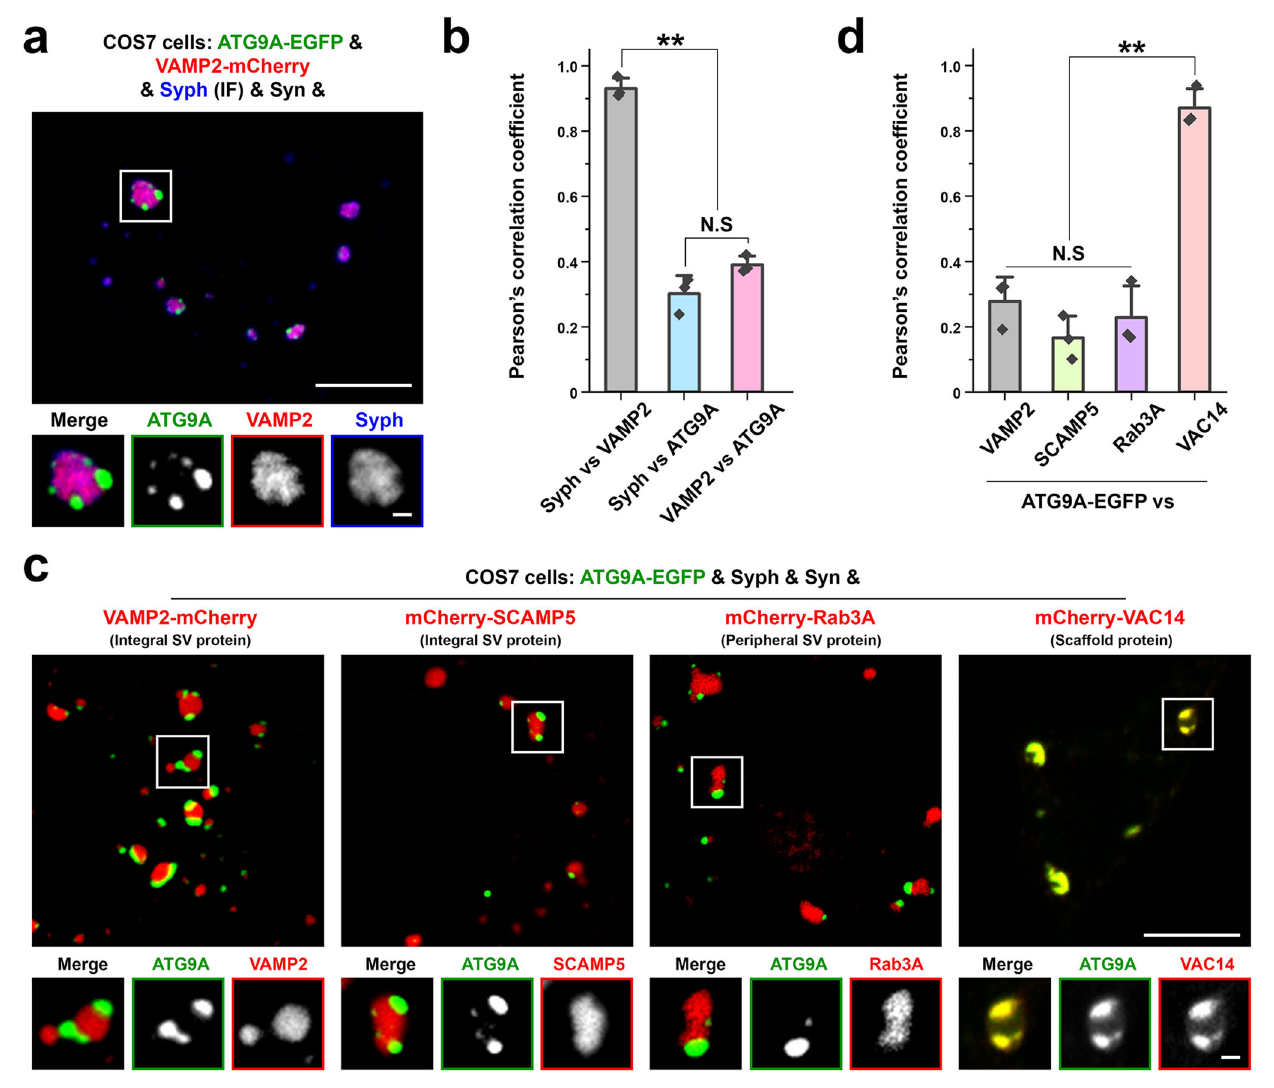
Fig. 6 | Validation of the proteomic analysis of ATG9A and synaptophysin vesicles. a Segregation of VAMP2-mCherry from ATG9A-EGFP in COS7 cells also expressing synapsin and synaptophysin. Synaptophysin was visualized by immu- no fl uorescence. b The colocalization of the pairs of proteins indicated was calcu- lated by Pearson ’ s coef fi cients. Values are means±SD; N.S., not signi fi cant; ** p <0.01byone-wayANOVAwithTukey ’ sHSDposthoctest(dropletsin3different cells were analyzed). c ATG9A is segregated from SV proteins (VAMP2, SCAMP5, Rab3A) but precisely colocalizes with VAC14 in COS7 cells also expressing synap- tophysinandsynapsin,consistentwithproteomicsdata. d Thecolocalizationofthe